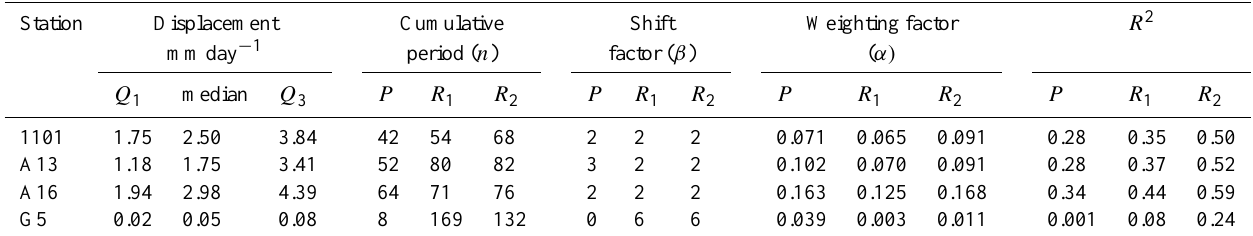
Table 2. Statistics of the displacement records and results of the best linear correlation between precipitation/ R LRIW and displacement records for four displacement stations (1101, A13, A16 and G5). The displacement column indicates basic statistics of the displacement records: first quartile ( Q 1 ), median and third quartile ( Q 3 ). Cumulative period ( n ), shift factor ( β ) and weighting factor ( α ) are the terms